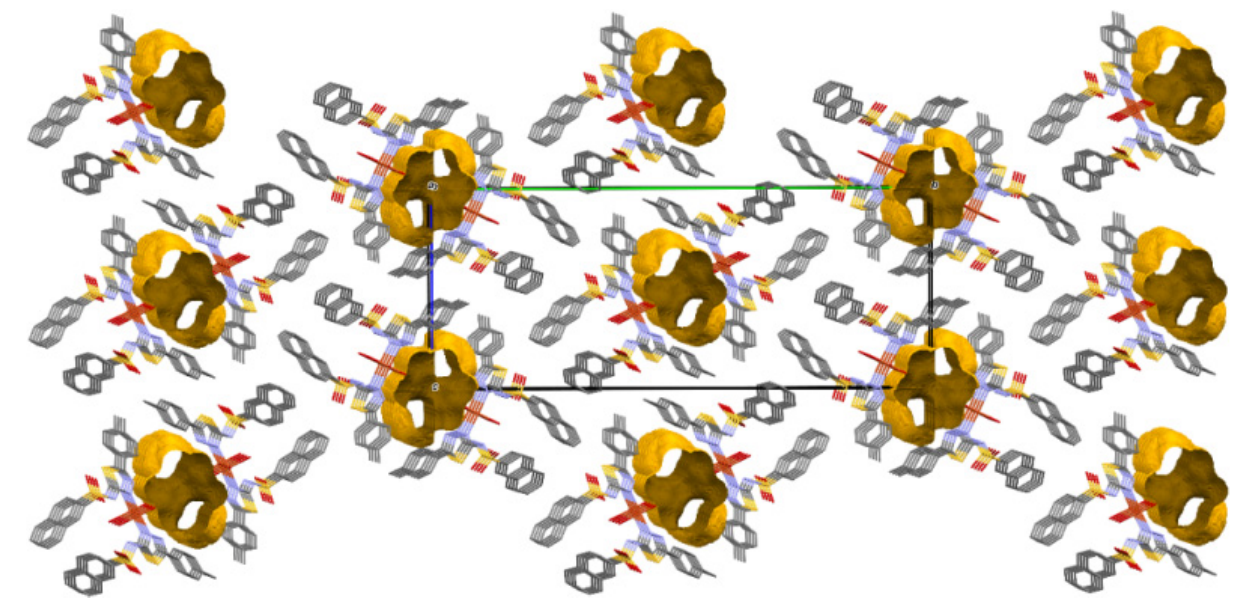
Figure 5. Structural voids in complex C1 .